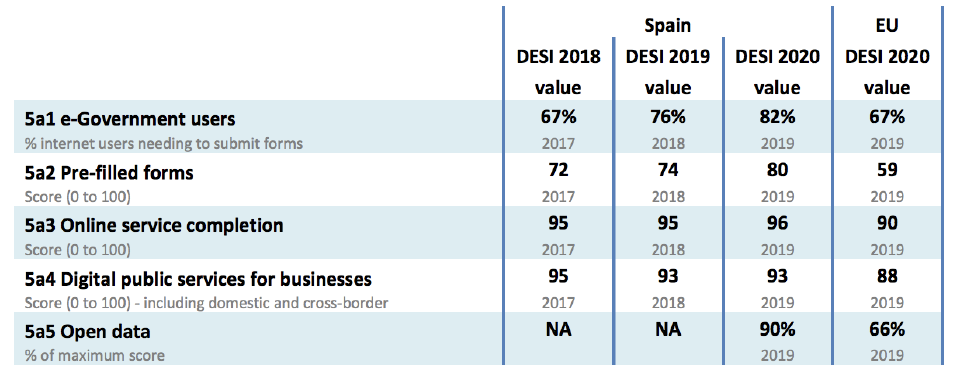
Figure 2: The Governmental Administration's Digital Transition (EU-28) (Source: European Commission